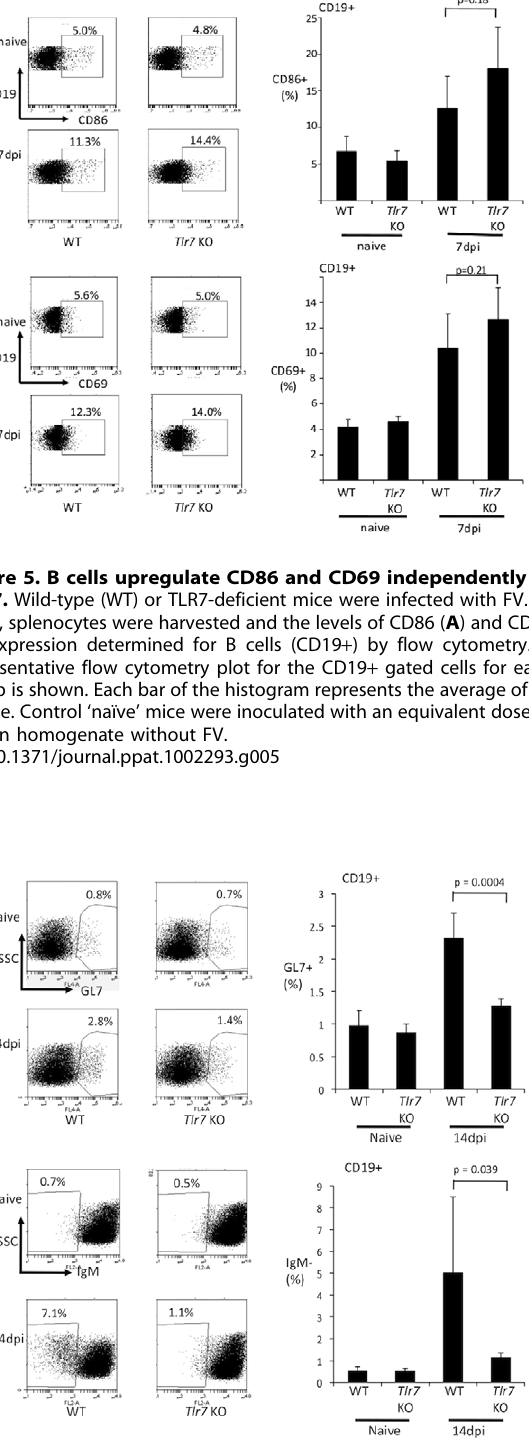
Figure 6. TLR7 is required for the development of germinal center B cells during FV infection. Wild type (WT) or TLR7-deficient mice ( Tlr7 KO) were infected with FV. At 14 dpi, splenocytes were harvested and analyzed for the presence of germinal center B cells by flow cytometry. The percentage of B cells that were ( A ) CD19 + , GL7 + or ( B ) CD19 + , IgM 2 were measured and plotted. A representative plot for the CD19 + gated cells for each group is shown. Each bar of the histogram represents the average of 5–6 mice.